Question: Which kind of chart has been used to present this data?
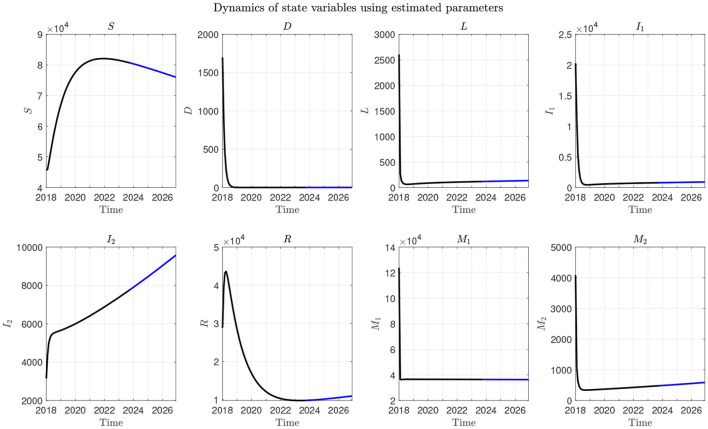
Answer: line